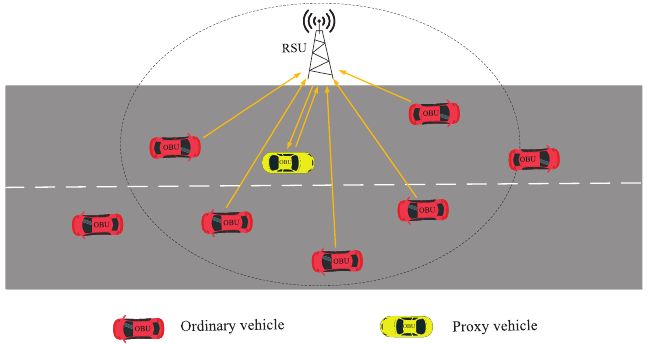
Figure 3. The information transfer path in the verification stage of the PVBA